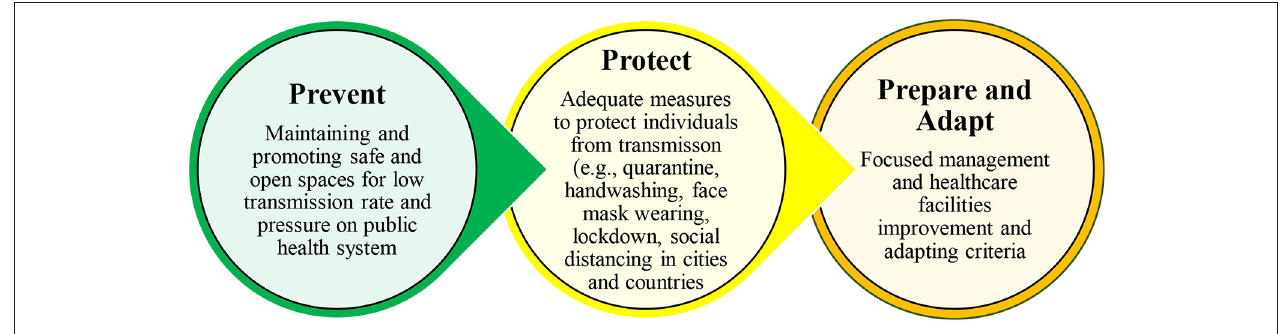
FIGURE 2 | Healthy pandemic-resilient strategy (three